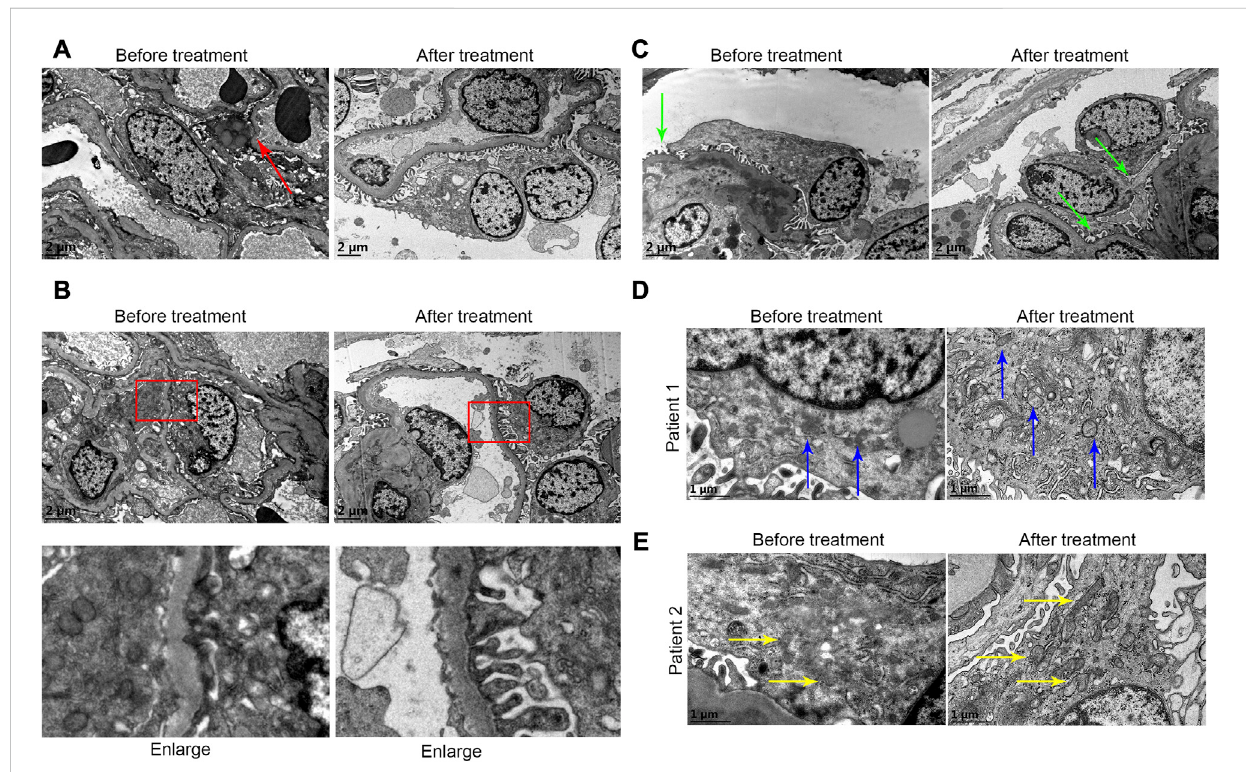
FIGURE 6 (A) In the fi rst renal puncture biopsy specimen, podocytes were fl at and apoptotic (as shown by the red arrow) before treatment. The foot cell morphology after treatment was improved. (B) It showed foot process fusion of podocytes before treatment. The shape of foot process of foot cells recovered after treatment. (C) The podocyte fi ssure membrane before treatment was more widened before treatment (green arrow). (D and E) From patients 1 and 2, respectively. (D and E) Before treatment it showed that the mitochondria in podocytes were indistinct, cristae were broken, and local vacuolization. The shape of mitochondria after treatment was improved (blue arrow and yellow arrow).